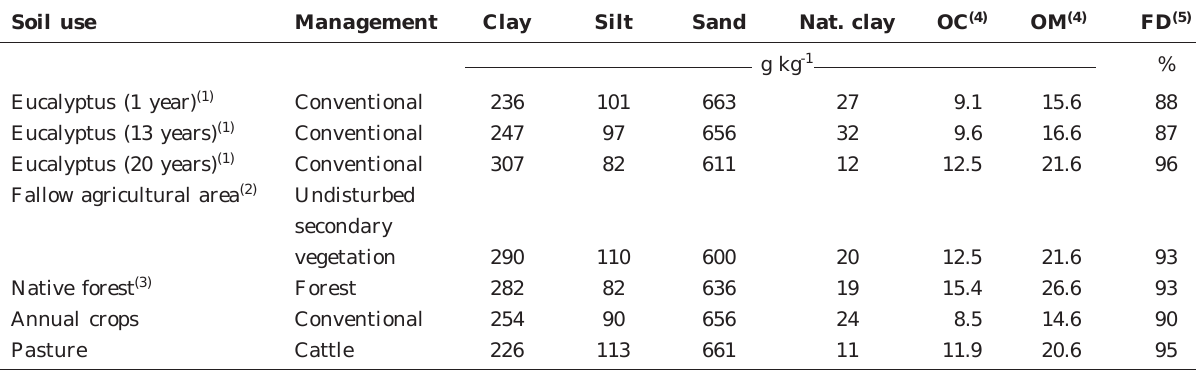
(1) Cultivation time in years; (2) Preserved for 20 years; (3) National Forest Araripe; (4) Organic carbon (OC) and organic matter (OM); (5) Clay flocculation